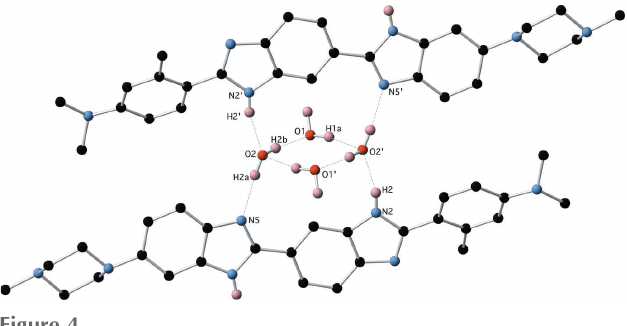
Figure 4 The water tetramer with diagonally hydrogen-bonded molecules of (1).